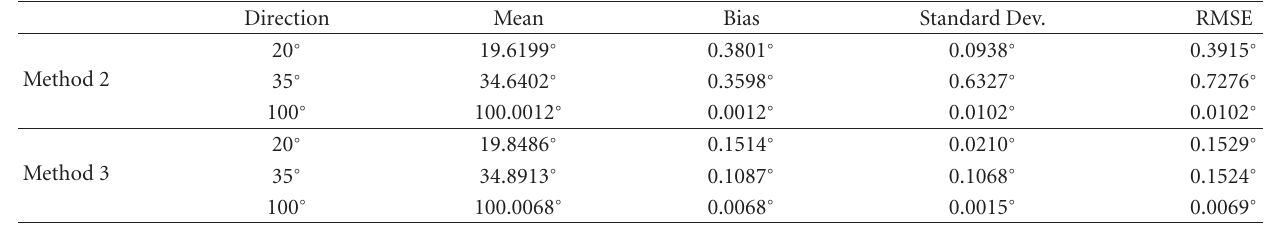
Table 1: DOA estimation using MPM using a ULA with 8 antenna elements with the element separation of Δ = 0 . 3 λ . DOA estimation is based on the decoupled voltages using RMI determined based on methods 2 and 3.